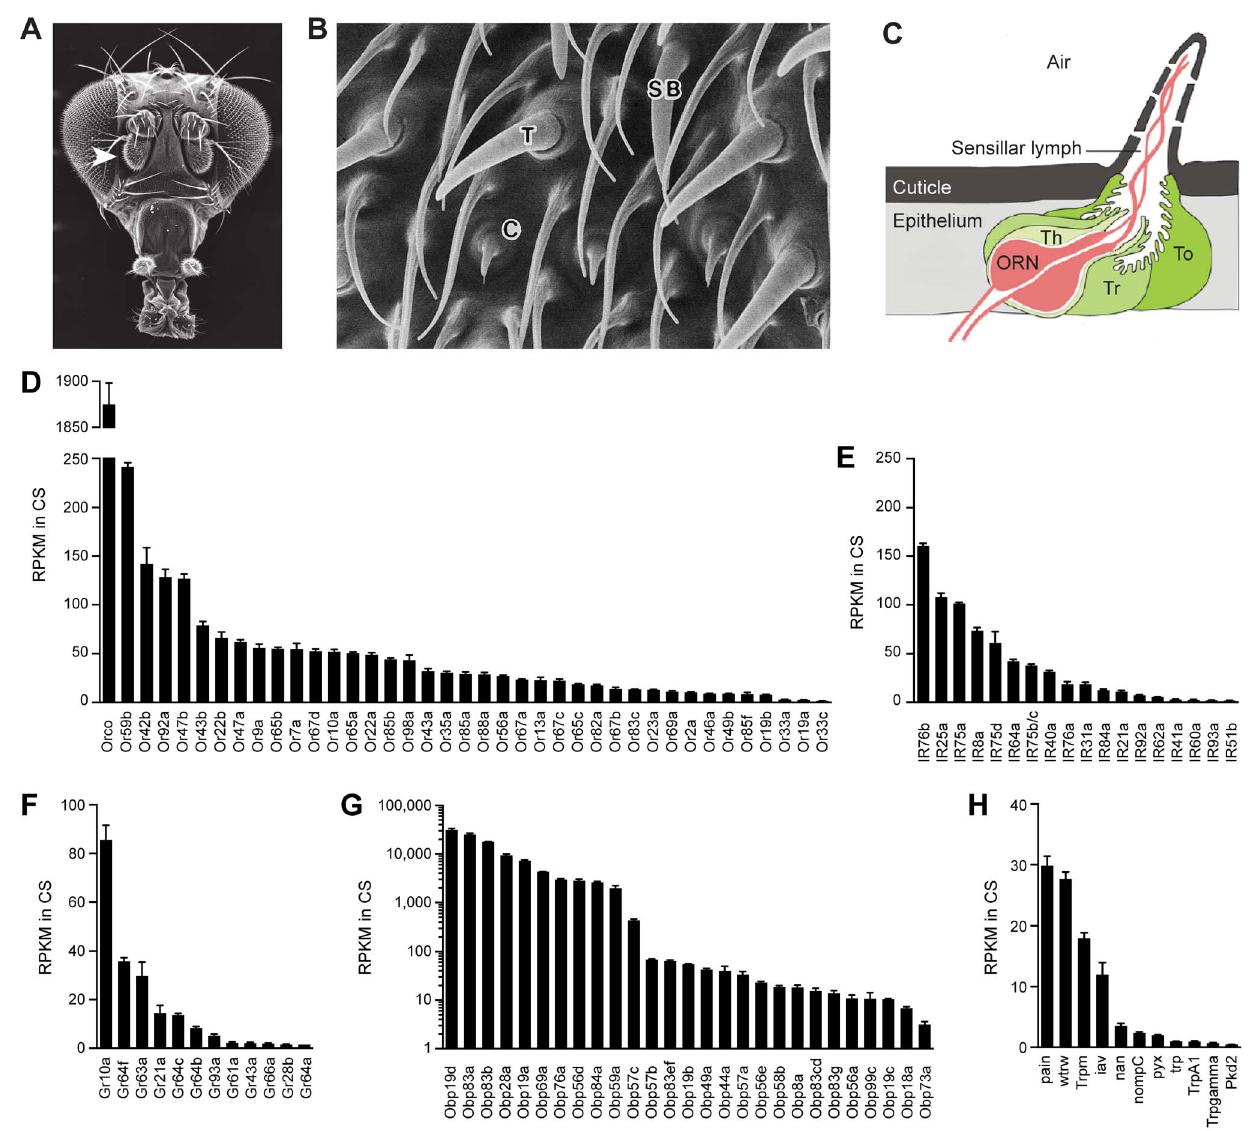
Figure 1. Chemosensory gene expression in the wild-type antennal third segment. (A) Third antennal segment (arrowhead) on a Drosophila head. (B) Scanning electron micrograph of the antennal surface with a coeloconic sensillum (C), trichoid sensillum (T) and small basiconic sensillum (SB) labeled. (C) Diagram of a generic sensillum containing an olfactory receptor neuron (ORN) whose dendrite is surrounded by sensillar lymph. The sensillum and antennal surface is covered with a cuticle, and pores in the sensillum cuticle permit airborne odors to enter the sensillum lymph. The sensillum is separated from other sensilla by the epithelium. Auxiliary cells, including tormogen (To), trichogen (Tr) and thecogen (Th) cells, surround the ORN. (D) Members of the Or and (E) IR olfactory receptor gene families detected in the Canton-S (CS) third antennal segment with at least 1 read per million mapped reads (RPM) in each of three samples. Genes are listed by decreasing reads per million mapped reads per kilobase of gene length (RPKM). Two IR genes, IR75b and IR75c, were annotated as a single gene, CG14586, at the time of the gene mapping (Dataset S1), and are therefore represented by a single bar in the graph. (F) Gr genes. (G) Obp genes. (H) Trp family genes. (A) is from http://cedar.bio.indiana.edu/ , ggrumbli/highrespackage, (B) is from [3], and (C) is adapted from